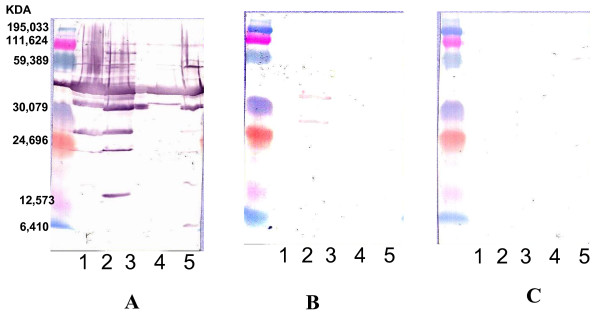
Western blotting using Bartonella antigen of a patient with IE. Western blotting was performed with the first serum sample from May 2005 at a 1:200 dilution. Molecular masses (in kilodaltons) are given on the left. A through C: Serum was analyzed by using B. quintana (lane 1), B. henselae (lane 2), B. elizabethae (lane 3), B. vinsonii subsp. Berkhoffii (lane 4) and B. alsatica (lane 5) antigens. (A) Untreated serum. (B) B. quintana-adsorbed serum. Antibodies to the B. henselae remained. (C) B. henselae-adsorbed serum. All antibodies were removed.